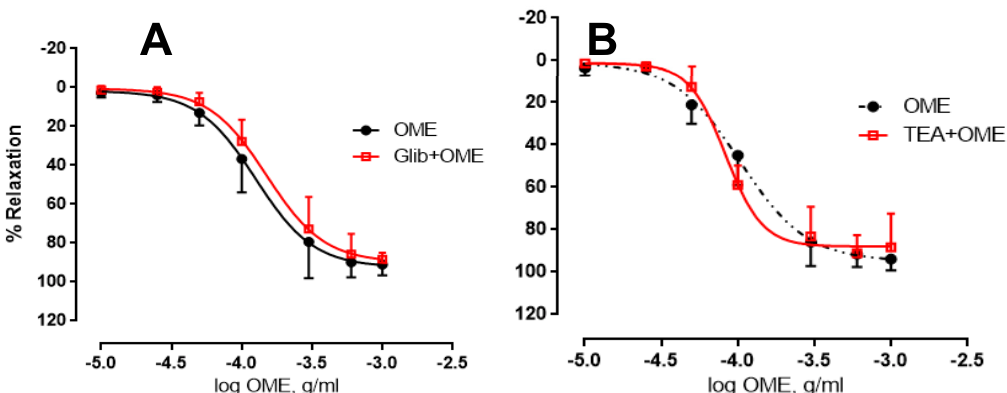
Figure 6. Effect of potassium channel inhibitors on OME-induced vasorelaxation. Rings with intact endothelium were treated with OME in the absence (OME; black) or presence of ( A ) 10 µM of glibenclamide (Glib + OME; red), or ( B ) 100 µM of tetraethylammonium (TEA + OME; red). Data represent mean ± SEM ( n = 6). p > 0.05 for OME alone vs. either Glib + OME or OME + TEA.